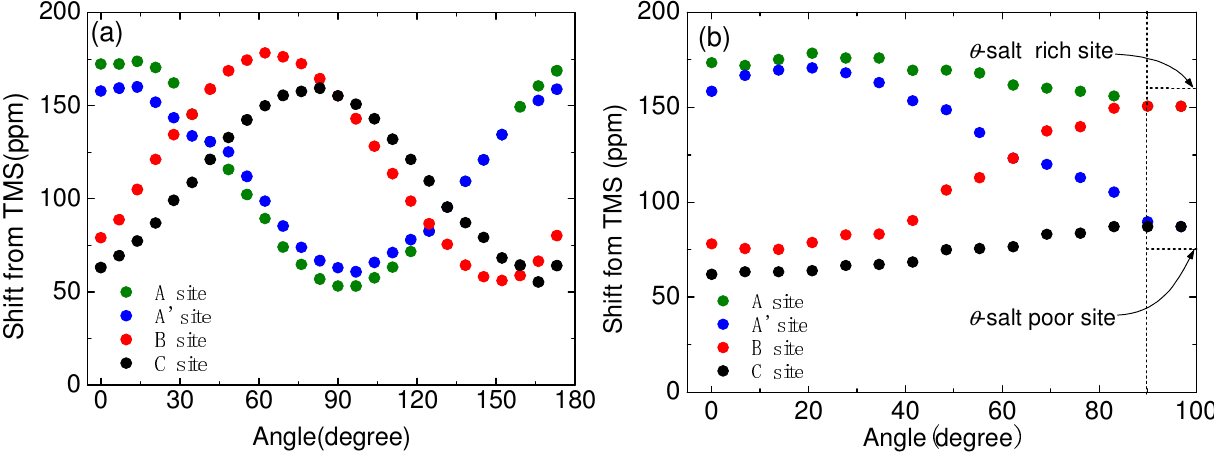
Figure 11. Angular dependence of the NMR shift of α -(BEDT-TTF) field in the ab plane and ( b ) the magnetic field rotated around the direction perpendicular to the conducting plane and parallel to the long axis of the BEDT-TTF molecule